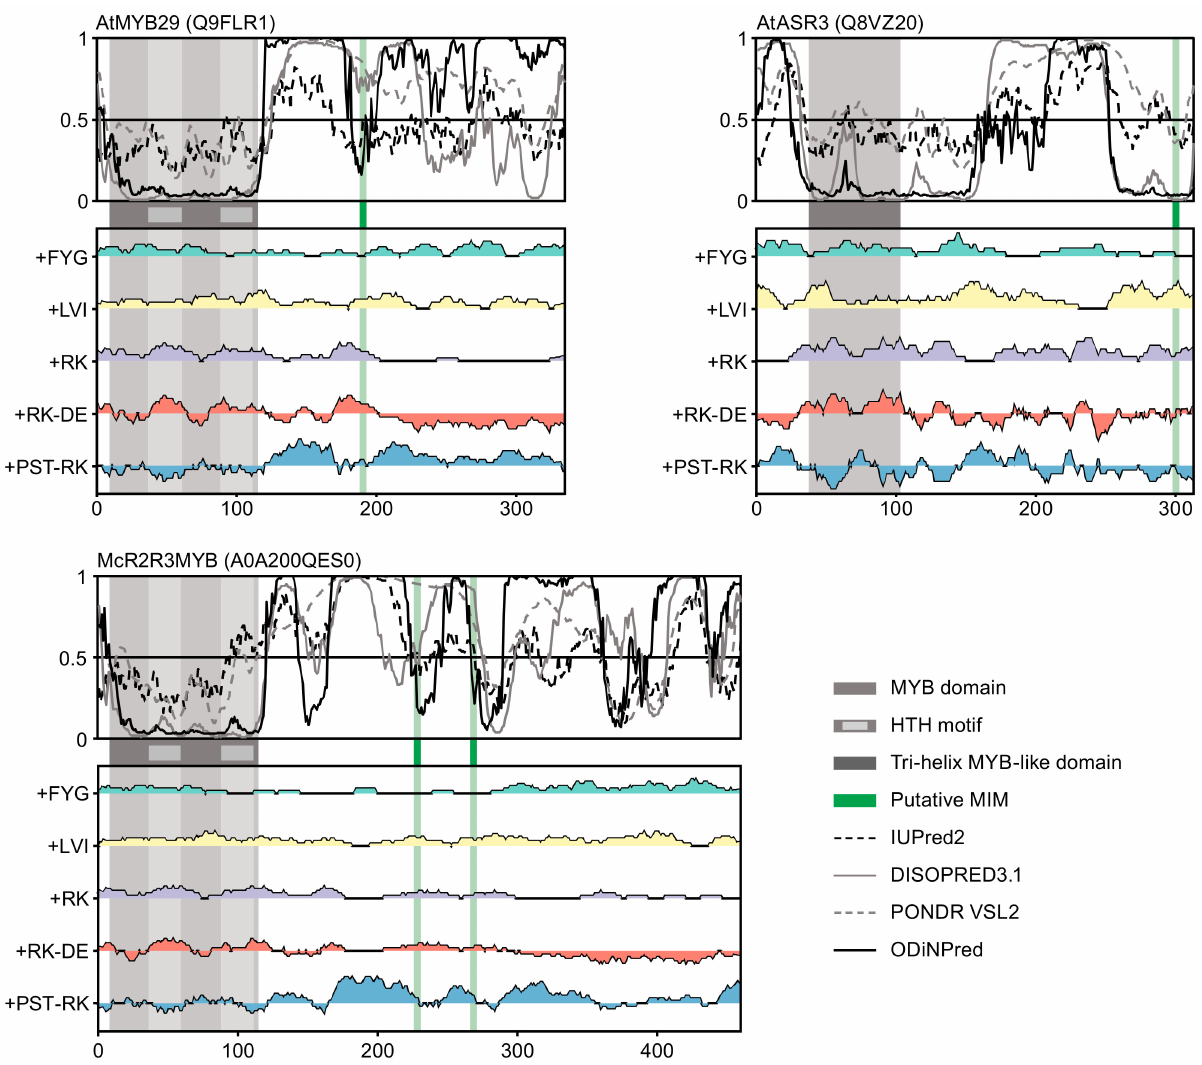
Figure 2. Disorder prediction and IDDomainSpotter profiles for putative MIM-containing proteins. Top panels show sequence-specific disorder predictions using IUPred2 [49], DISOPRED3.1 [50], PONDR VSL2 [51,52], and ODiNPred [53]. Bottom panels show IDDomainSpotter profiles: Each curve shows the fraction of a different set of residues within sliding windows of 15 residues [48]. Domain information was obtained from PROSITE [41]. The putative motif is shown by a green